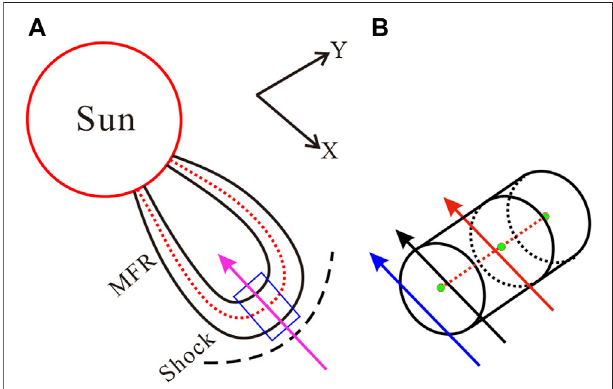
FIGURE 1 | Schematic drawing of the spacecraft trajectory crossing an ICME. The black dashed and solid lines represent the shock and MFR, respectively.ThereddottedlinesdelineatetheMFRaxis.TheICMEnoseportion ismarked withthe blue rectangle inPanel (A) , which isenlargedfor details inPanel (B) .Theblue,black,andredarrowsdescribethedifferenttrajectoriesof spacecraft, and the green dots denote the center of each cross